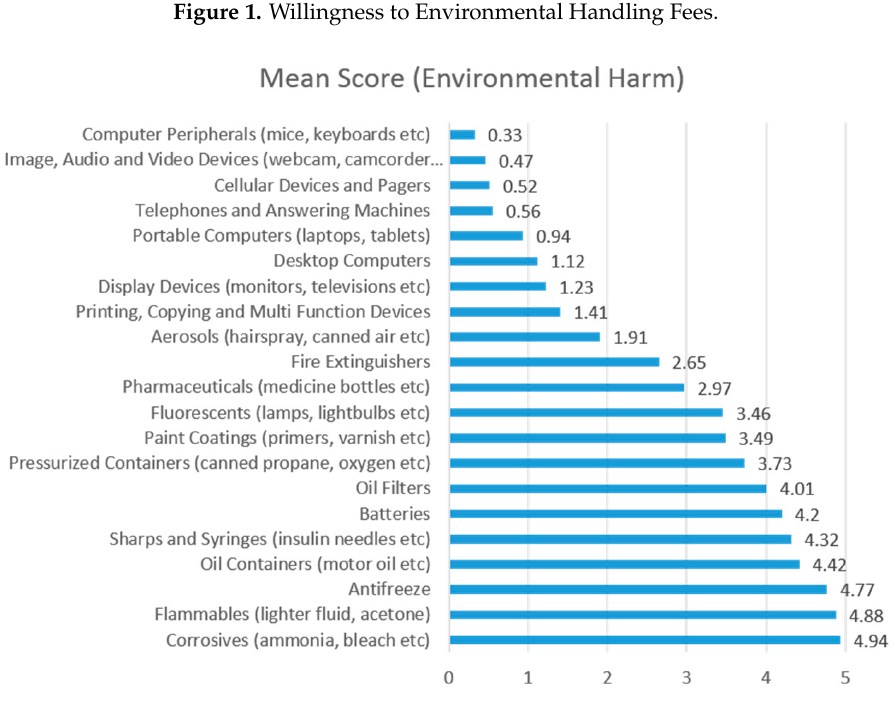
Figure 2. Perception of Environmental Harm.